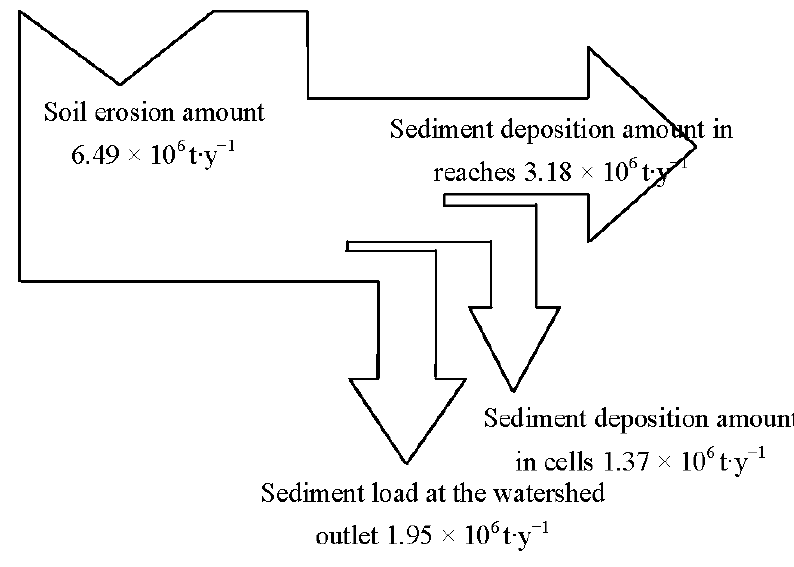
Figure 4. Annual sediment budget for Daning River watershed predicted by AnnAGNPS. Arrow thickness is proportional to the amount of sediment input or